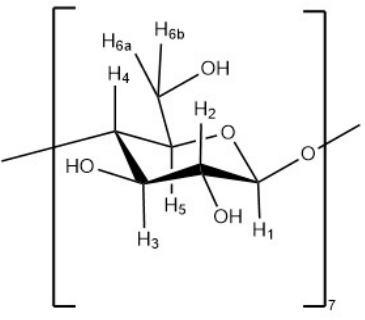
Figure 7. Structure of the repeating unit of β -CD. Protons are labeled according to their assignment for the NMR analysis.